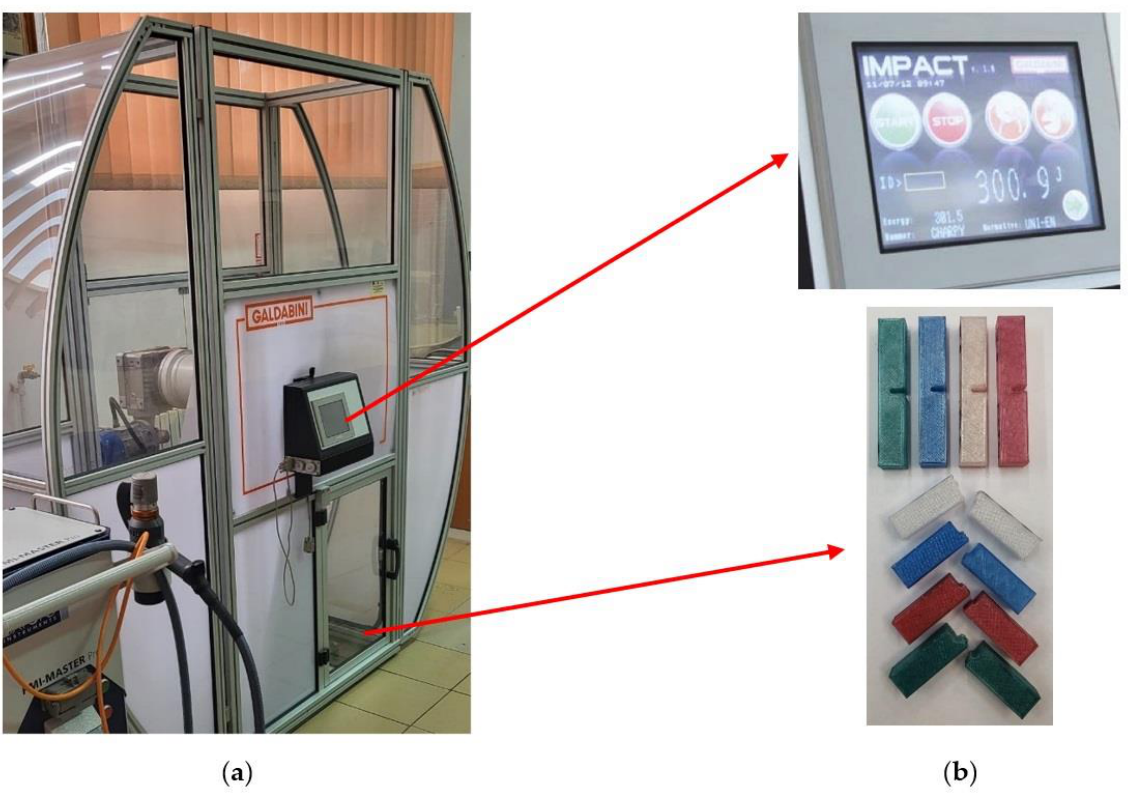
Figure 10. Tensile testing stand: ( a ) Galbadini Impact 300; ( b ) tested specimens and value recording. Sq surface roughness values were obtained using the Mahr MarSurf CWM 100 confocal microscope and interferometer (Figure 11a), and surface topography (Figure 11b) was analysed using the related MountainsLab 8.1 software. Sq is a surface texture